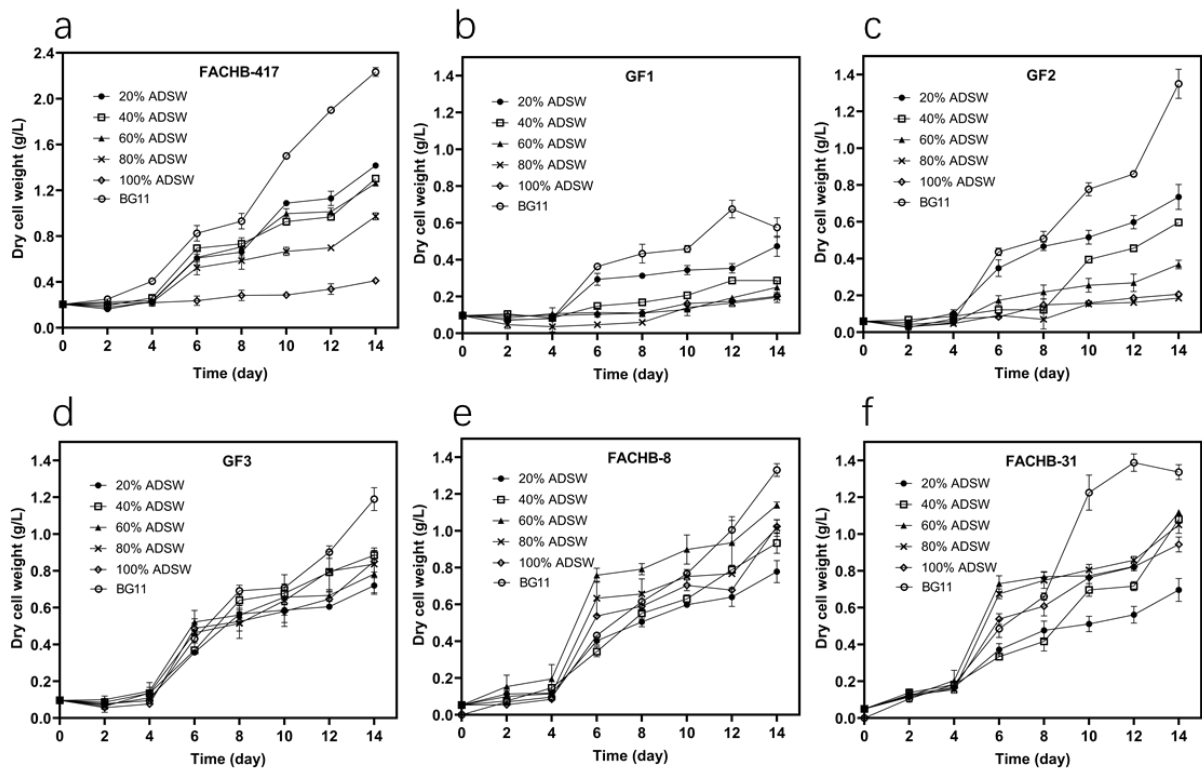
Figure 1. Growth curves for six microalgal strains in five dilutions of ADSW and BG11 medium within 14 days. ( a ) S. obliquus FACHB-417, ( b ) C. zofingiensis GF1, ( c ) C. protothecoides GF2, ( d ) C. pyrenoidosa GF3, ( e ) C. vulgaris FACHB-8, and ( f ) Chlorella sp. FACHB-31. Error bars represent SD ( n = 3).